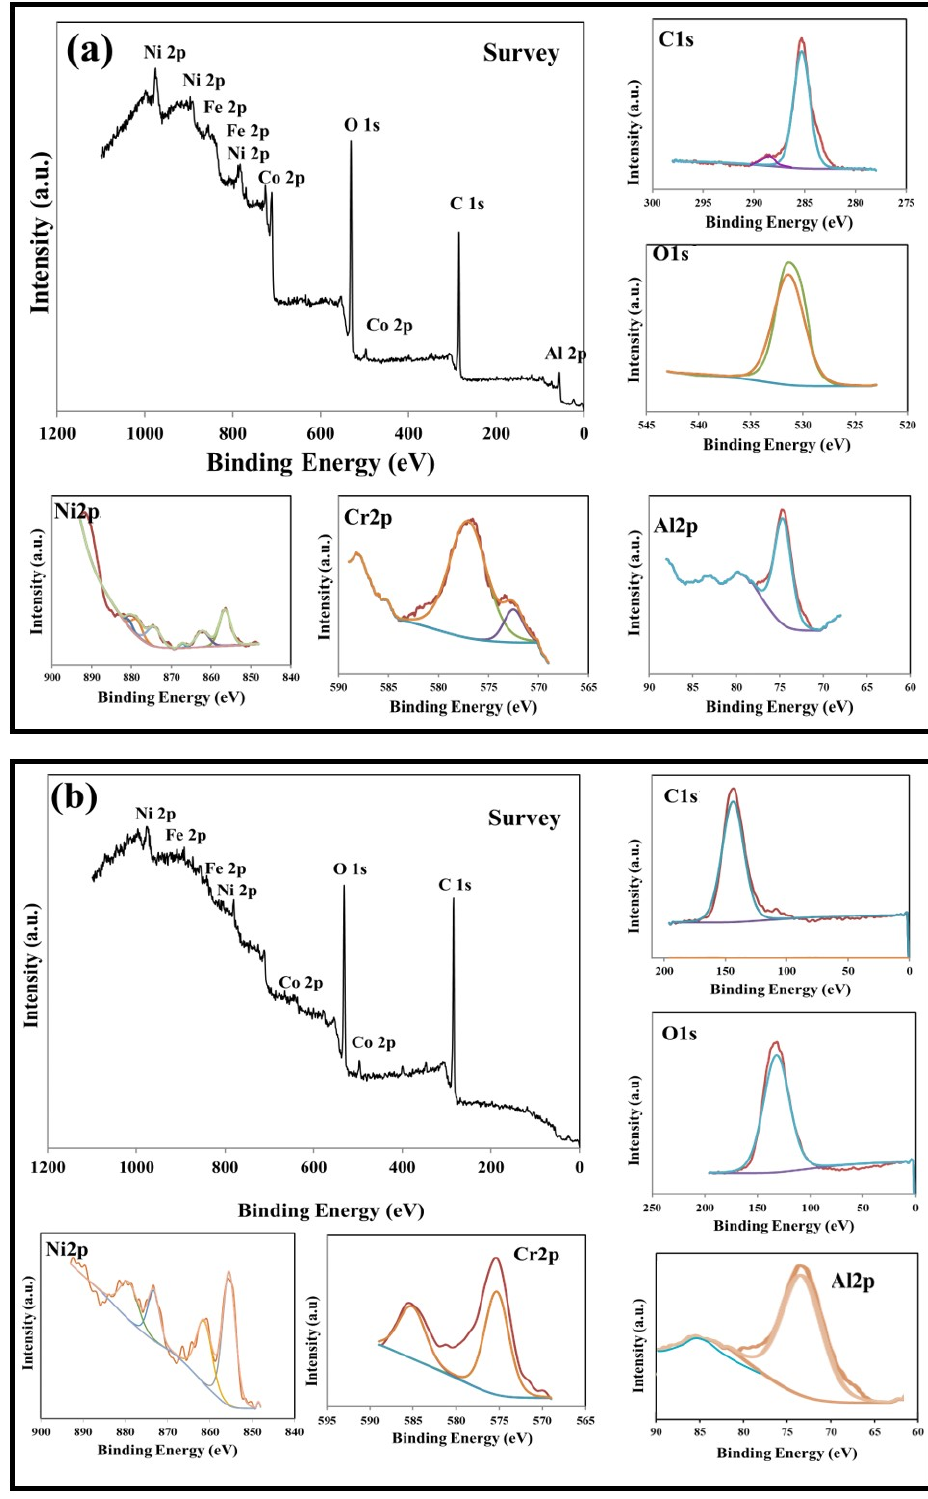
Figure 7. XPS results (survey peaks as well as high-resolution spectra of C1s, O1s, Ni2p, Cr2p and Al2p peaks) of the surface of the AlCrFeCoNi HEA coating after 50 cycles of the oxidation at 1100 °C: ( a ) microcrystalline coating and ( b ) nanocrystalline coating.